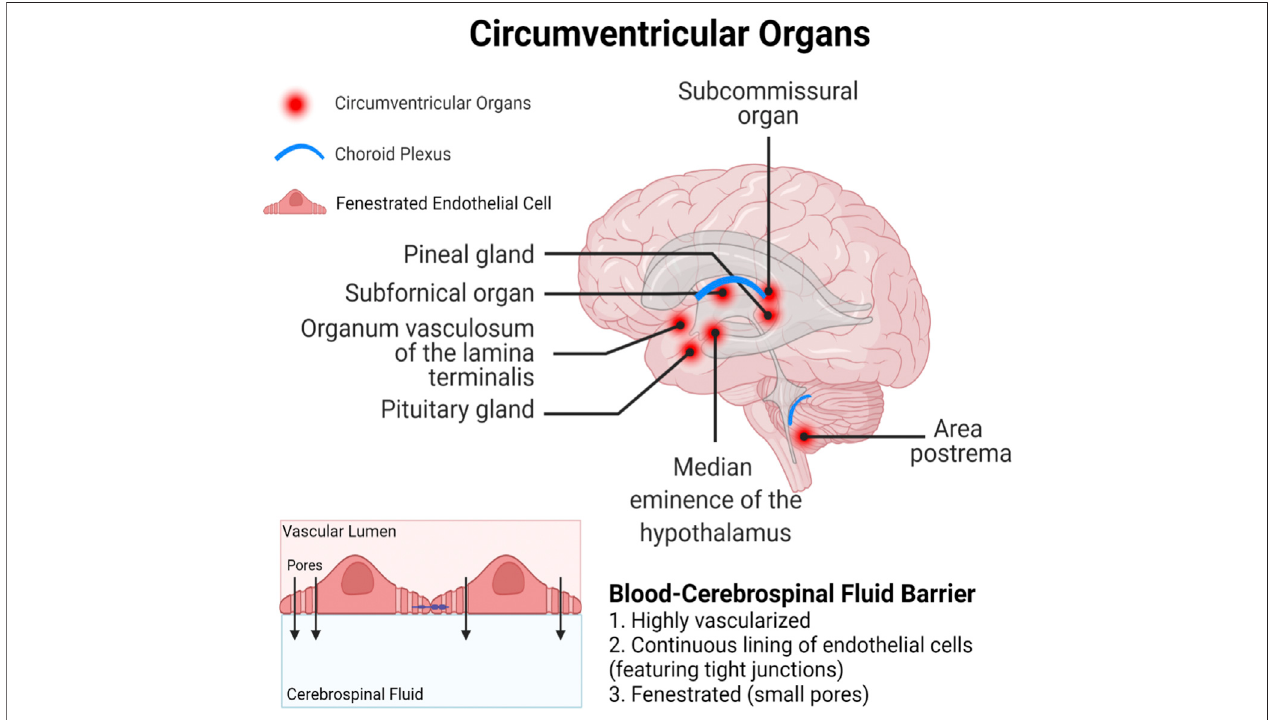
FIGURE 3 | Circumventricular organs represent a particularly vulnerable site for xenobiotic entry, as they are in close proximity to the blood-cerebrospinal fl uid barrier which is lined with fenestrated (porous) endothelial cells.